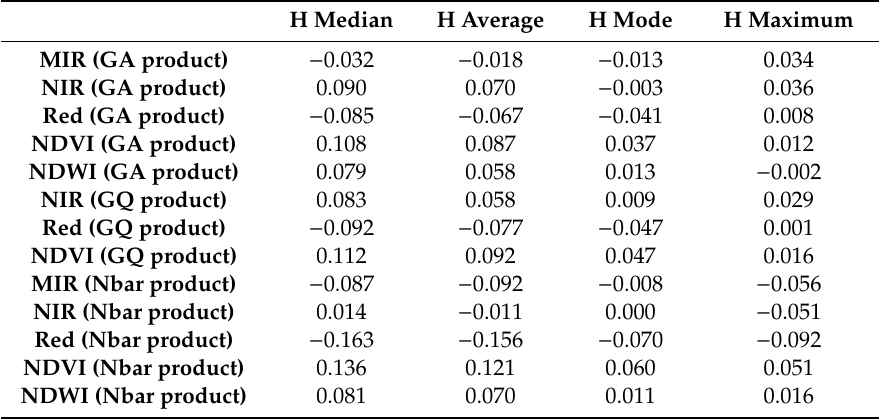
Table 3. Pearson correlation coe ffi cients between height (median, average, mode, and maximum value) and daily MODIS satellite variables for all